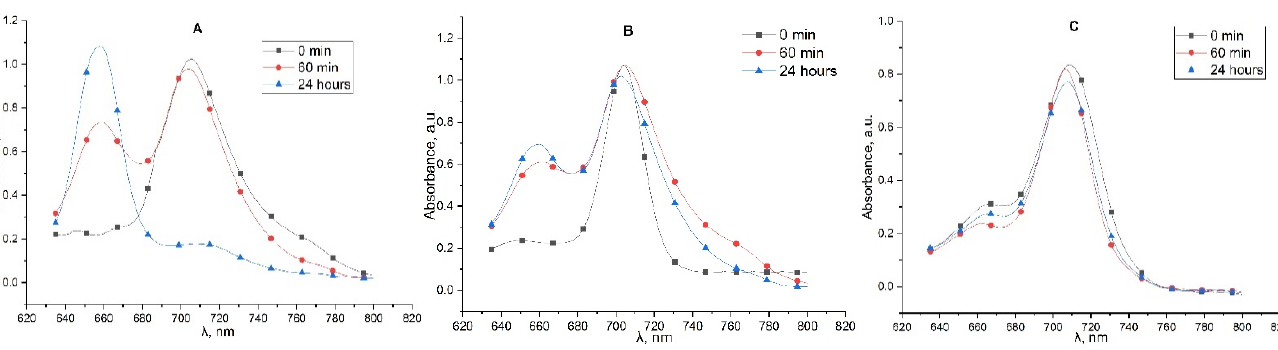
Table 1. Intensity of the absorption maxima of compounds ( 1 ), ( 3 ), and ( 4 ) under acidic conditions at pH = 4. Time, min.